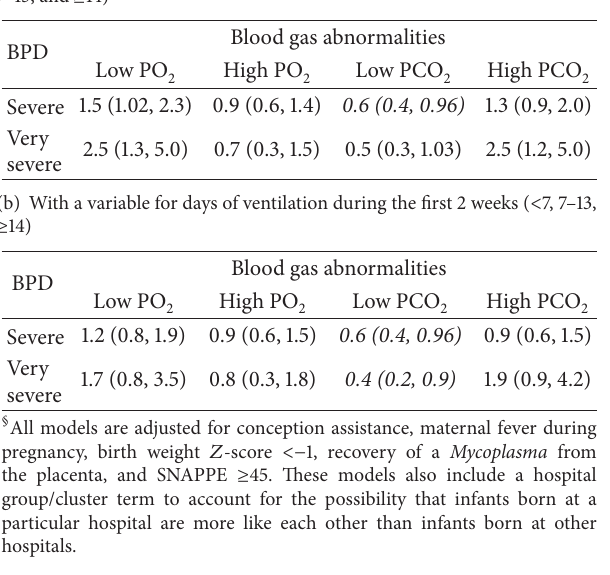
Table 4: Odds ratios (and 95% confidence intervals ) § of the associationbetweenbloodgasabnormalities(definedastheextreme quartile for gestational age on at least two of the first three days) and BPD. The referent group consists of all infants who did not have severe or very severe BPD. The sets of tables differ in the inclusion/exclusion of one variable in the multivariable models. In the top set, days of ventilation during the NICU stay ( < 7, 7–13, ≥ 14) are not included in the model, while this variable is included in the bottom set. (a) Without a variable for days of ventilation during the first 2 weeks ( < 7, 7–13, and ≥